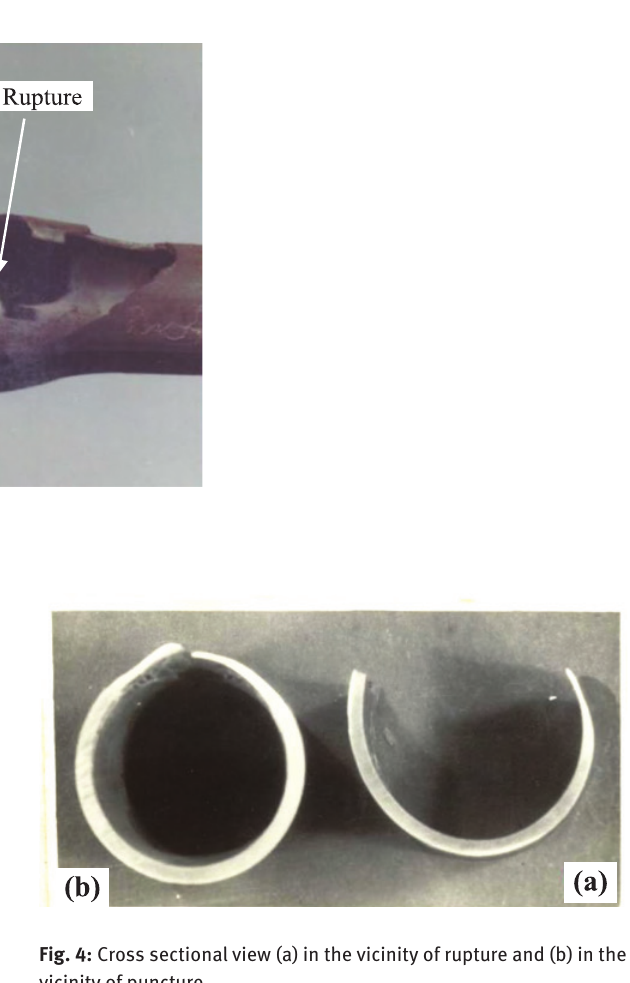
Fig. 2: Internal tube surface showing oxide scale. Fig. 3: Photograph away from the rupture region showing formation of oxide scale on the steam side. Fig. 3. Dimensional measurement of the tube revealed that the reduction of wall thickness at the location of failure was almost 33% whereas the increment in diameter of the tube at the vicinity of damage due to swelling was found